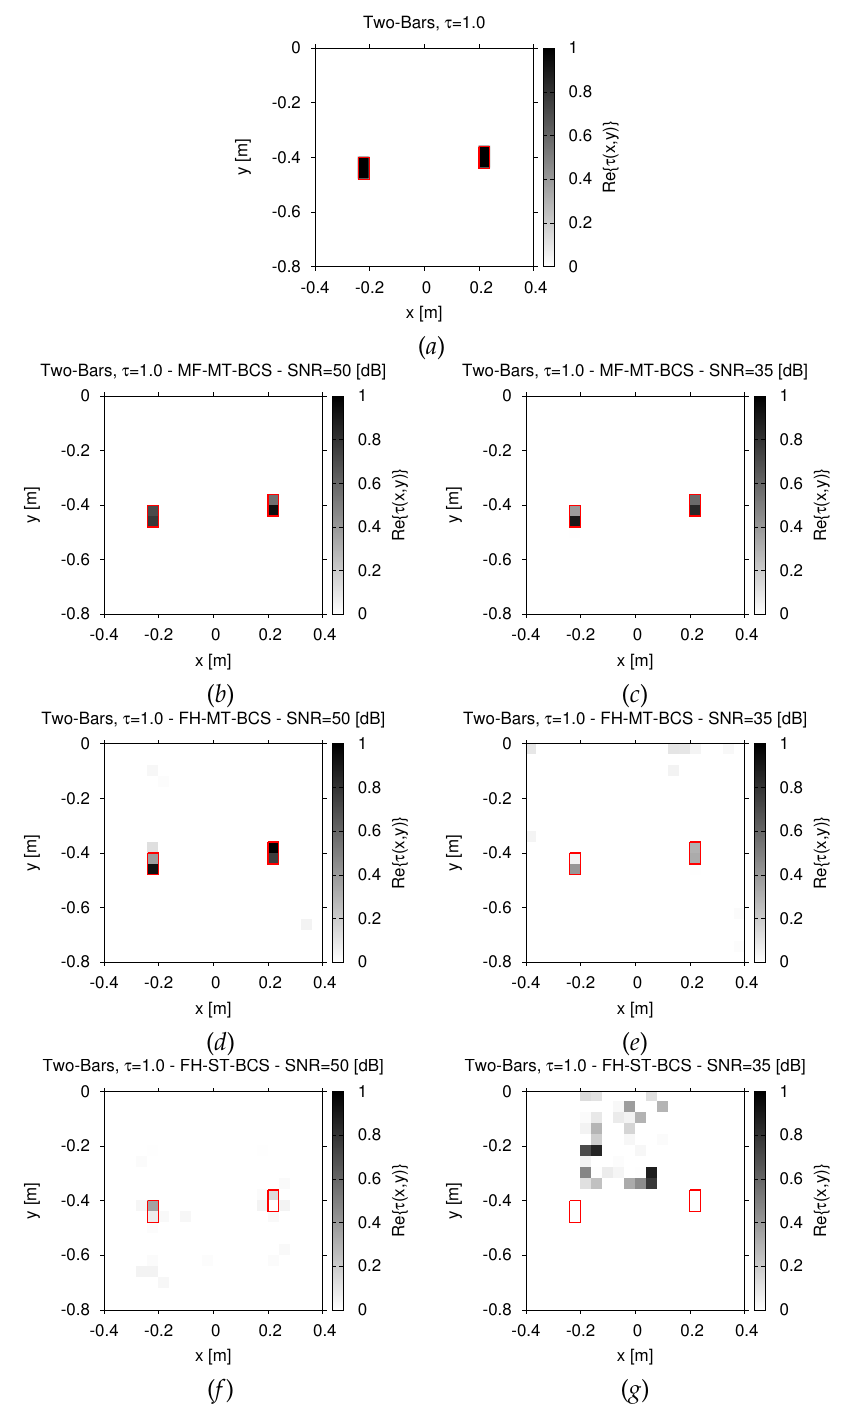
Figure 2. Numerical assessment (“ Two-Bars ” Scatterer , τ = 1.0, N = 400)—Actual ( a ) and retrieved ( b – g ) dielectric profile by ( b , c ) the MF-MT-BCS , ( d , e ) the FH-MT-BCS , and ( f , g ) the FH-ST-BCS when processing noisy data at ( b , d , f ) SNR = 50 dB and ( c , e , g ) SNR = 35